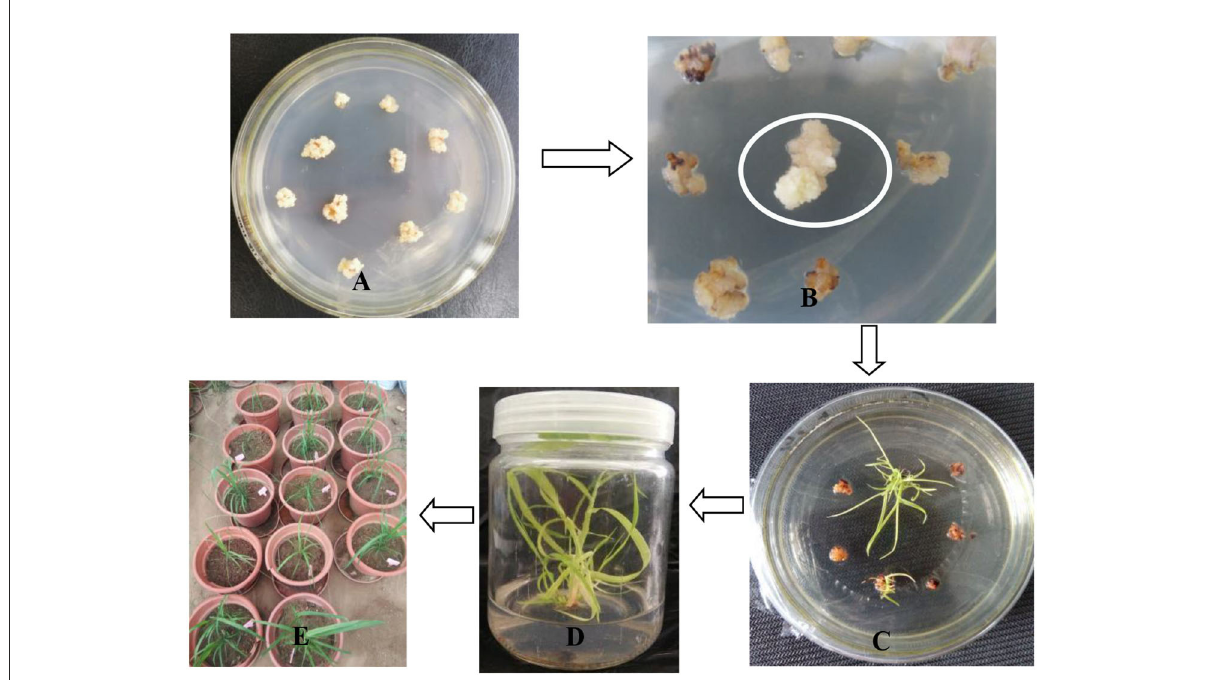
FIGURE5 Genetic transformation and resistant shoot selection. (A) Embryogenic calli prepared for transformation. (B) After 30 days of calli selection, resistant calli sprouted and grew healthily on the selection medium. (C) After 14 days of regeneration, healthy resistant calli emerged rapidly. (D) After 28 days of elongation, dark-green shoots grew quickly. (E) Resistant shoots were transplanted in the